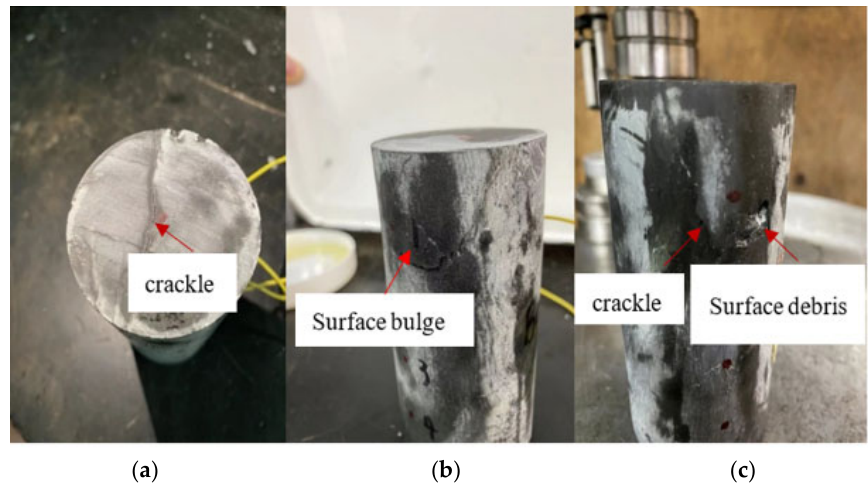
Figure 11. External damage of rock sample during uniaxial graded cyclic loading and unloading. ( a ) B02; ( b ) B04; ( c ) B05.